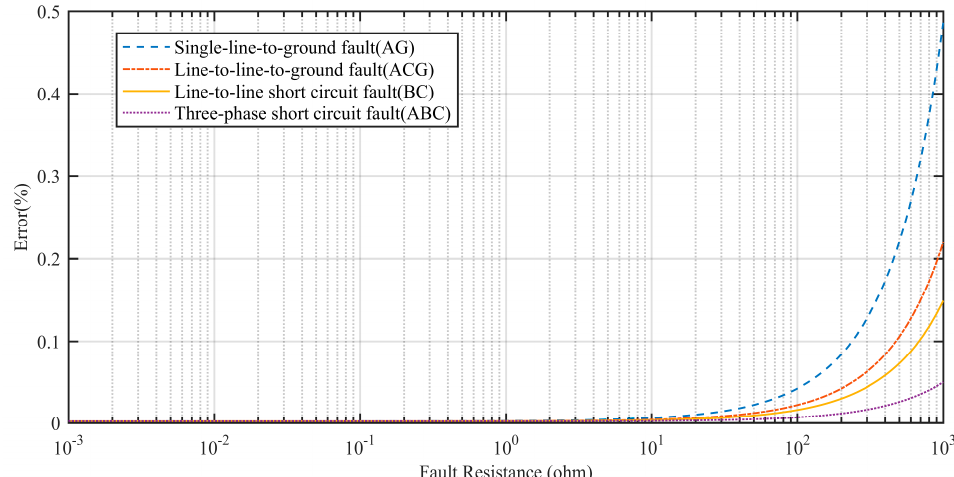
Figure 13. Impact of the fault resistance.